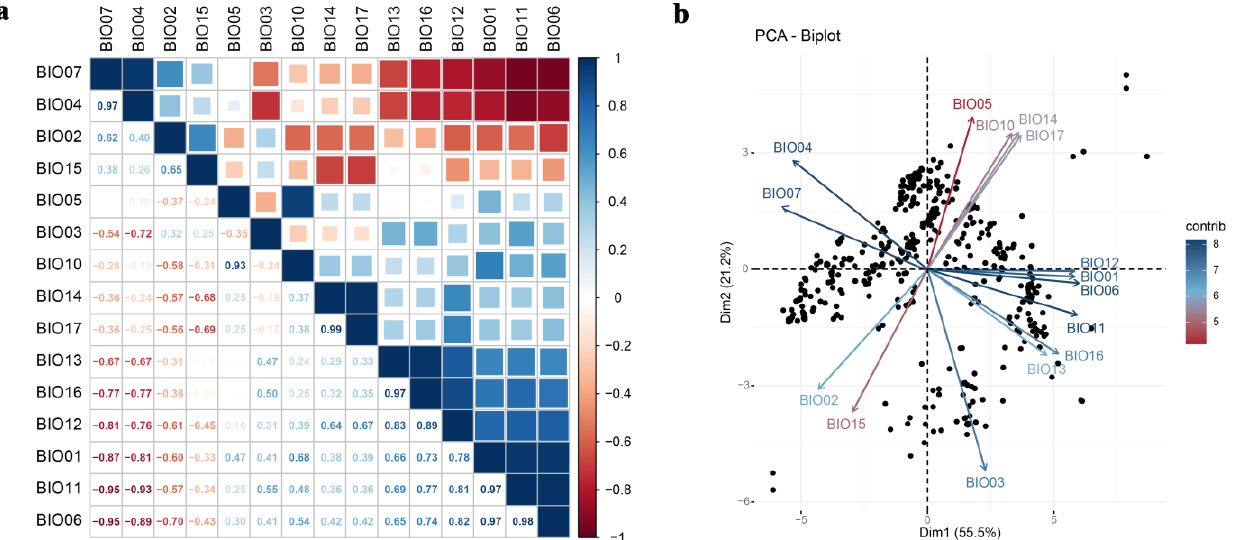
Figure 2. PCC (person correlation coefficient) and PCA (principal component analysis) of climatic factors. ( a ) Person correlation coefficient; ( b ) principal component analysis. Table 1. Bioclimatic variables used in the model.